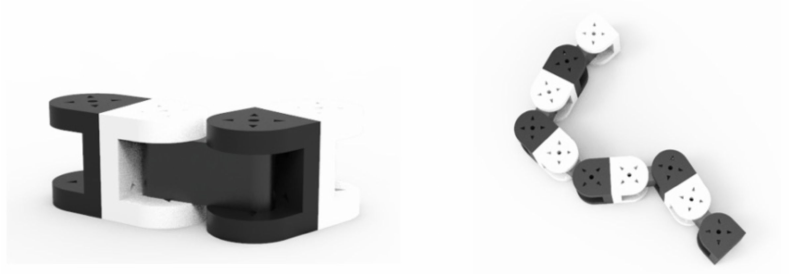
Figure 2. M-TRAN III modular robot.